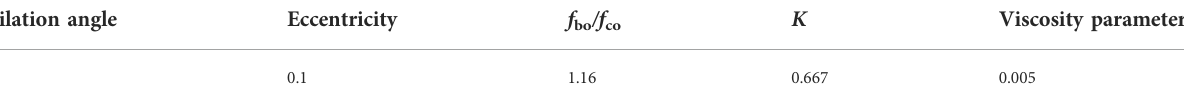
TABLE 2 Material parameters of concrete.